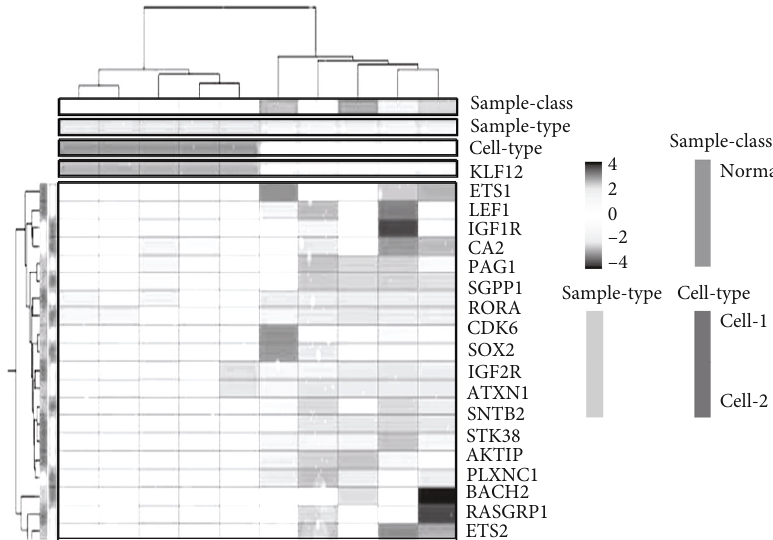
Figure 4: Results of gene di ff erence analysis.